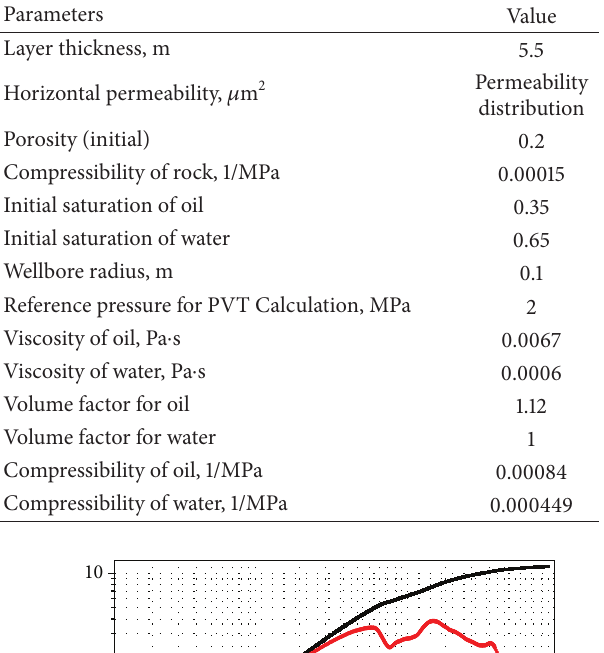
Table 5: Parameters for calculation.